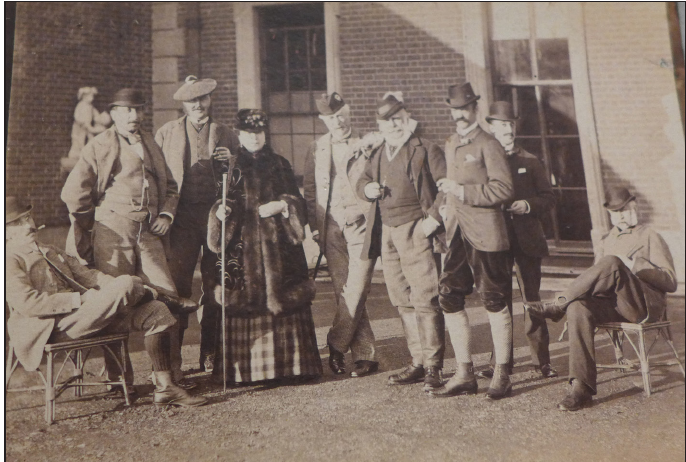
Fig. 8 : Sir Richard and Lady Wallace with guests at Sudbourne Hall in January 1883. Sir Richard and Lady Wallace stand together at the centre; John Murray Scott, wearing a flat cap, stands behind Lady Wallace. Private